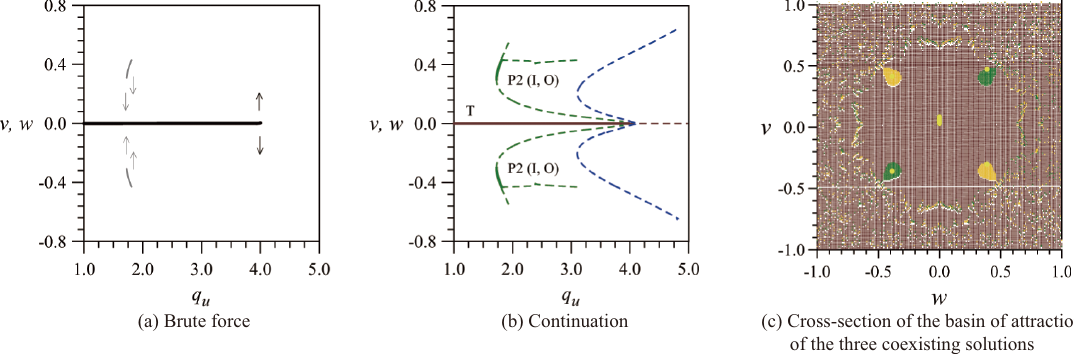
Fig. 11. Bifurcation diagram and basin of attraction in the secondary parametric instability region at Ω u = ω 0